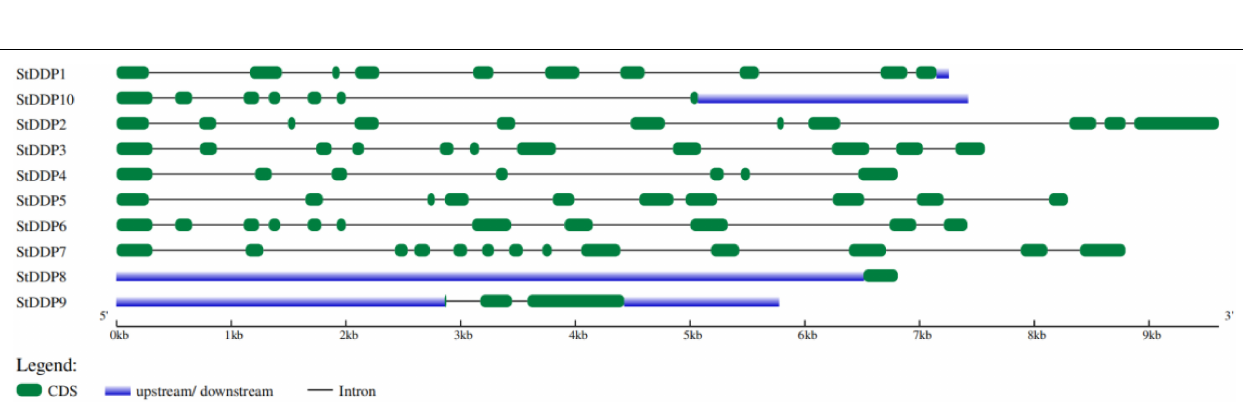
Frontiers in Plant Science |